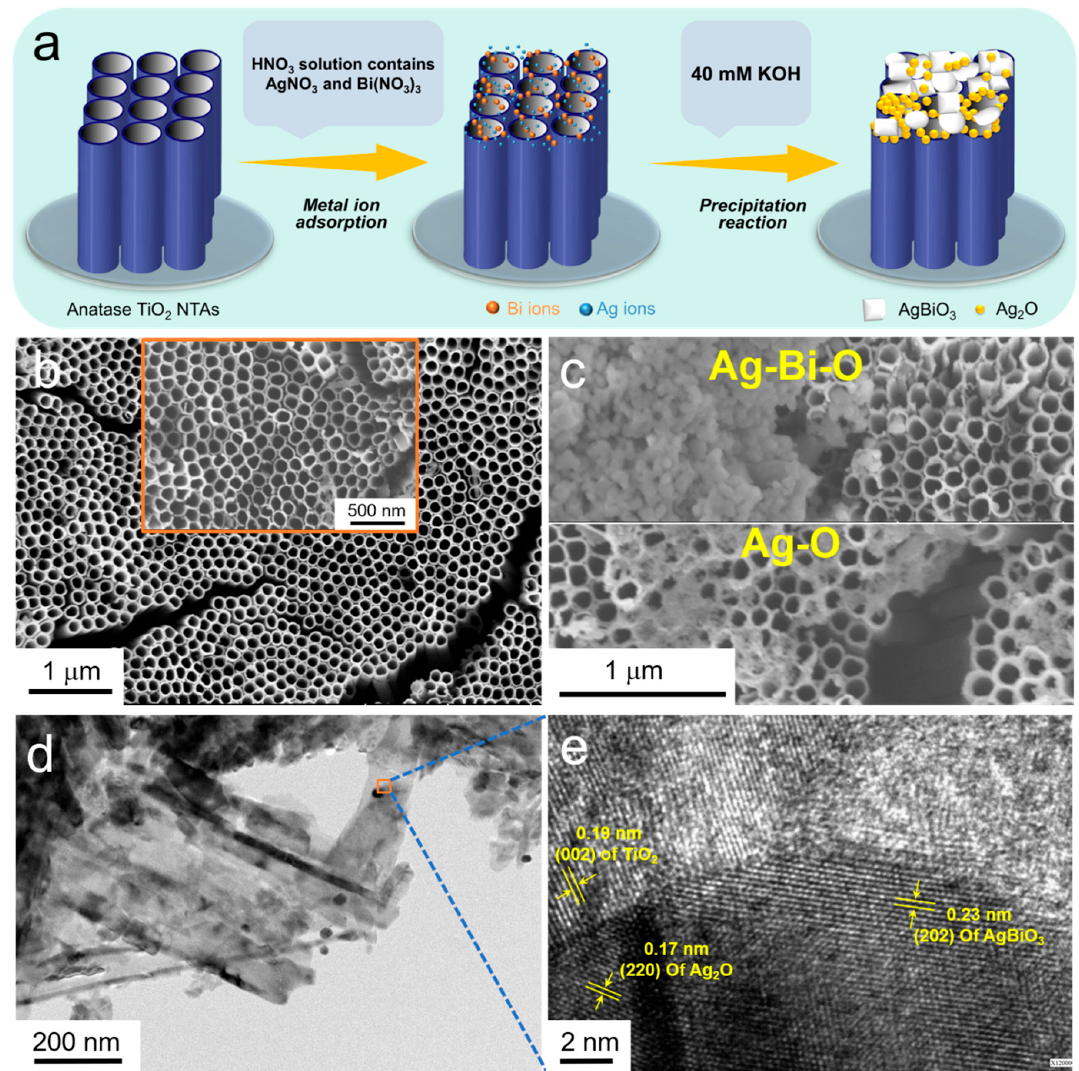
Figure 1. Schematic synthesis process and the corresponding morphology characterization of the co-modified titanium dioxide nanotube arrays (TiO 2 NTAs). ( a ) Schematic representation of a two-step process to prepare co-modified TiO 2 NTAs. ( b ) SEM image of pristine TiO 2 NTAs. ( c ) SEM image, ( d ) TEM image, and ( e ) high-magnification TEM image of co-modified TiO 2 NTAs.